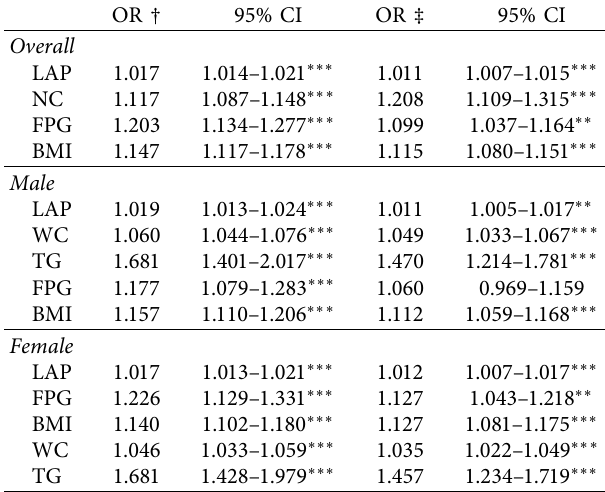
Table 5: Multivariate logistic regression analysis of factors asso- ciated with hypertension.